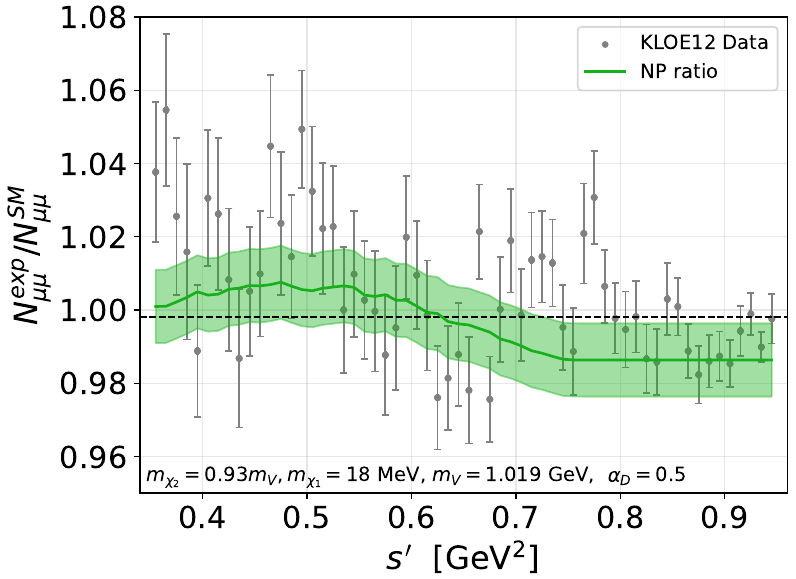
for our iDM model with m = /N SM χ 2 µµ µµ